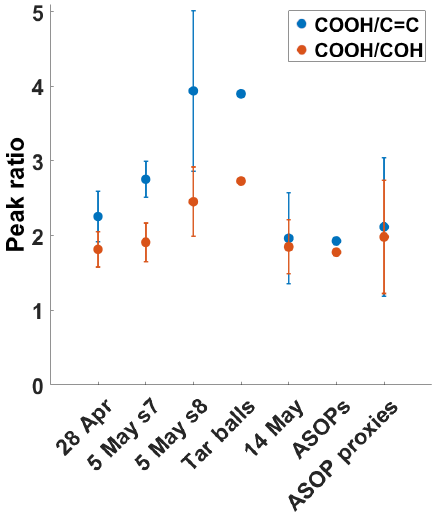
Figure 6. Plot of peak ratios for (blue dots) carboxylic acid peak at 288.6eV and the carbon double bond peak at 285.3eV and (red dots) carboxylic acid peak and the COH peak at 286.7eV. ASOP proxies refer to particles generated via bubbling through the aquatic sample of